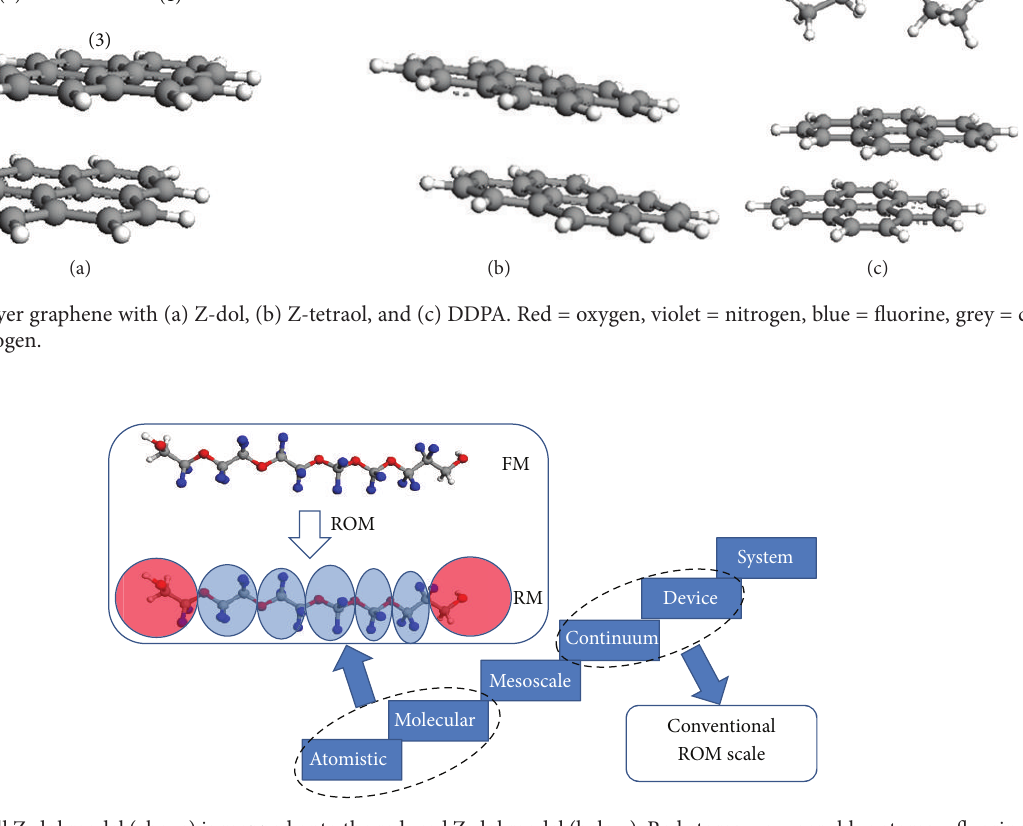
Figure 10: The full Z-dol model (above) is mapped onto the reduced Z-dol model (below). Red atoms = oxygen, blue atoms = fluorine, white atoms = hydrogen, and grey atoms =